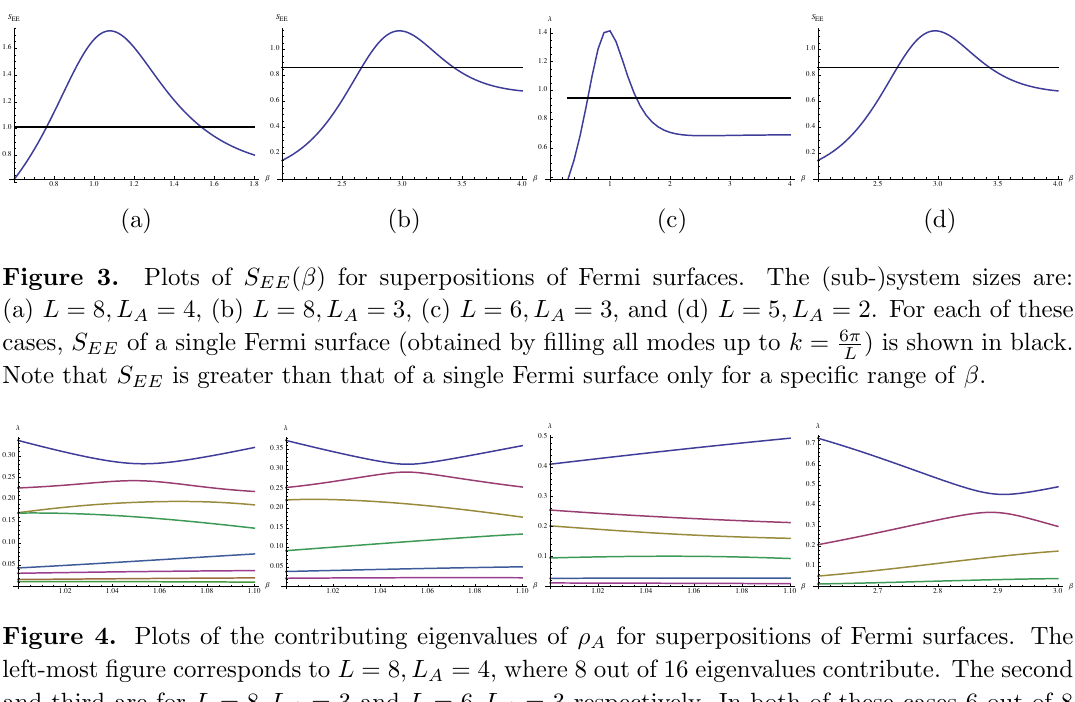
Figure 4. Plots of the contributing eigenvalues of (cid:26) A for superpositions of Fermi surfaces. The left-most (cid:12)gure corresponds to L = 8 ; L A = 4, where 8 out of 16 eigenvalues contribute. The second and third are for L = 8 ; L A = 3 and L = 6 ; L A = 3 respectively. In both of these cases 6 out of 8 eigenvalues contribute. The right-most plot is for L = 5 ; L A = 2, where all 4 eigenvalues